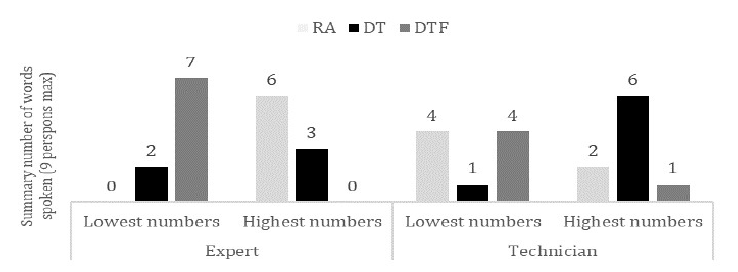
Figure 11. Number of spoken words per participant, and per system. With the DTF, seven out of nine experts used the lowest number of words, closely followed by the DT (six out of nine), whereas the RA led to the highest number of words spoken (six out of nine